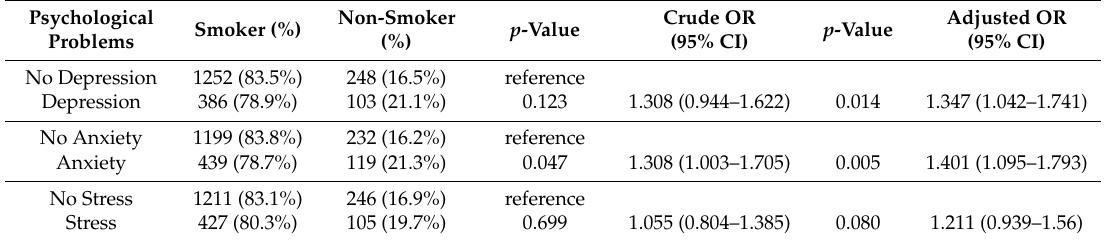
Table 4. Relationship between Depression Anxiety Stress Scale and